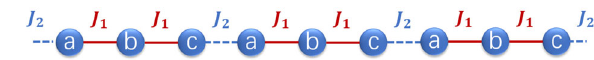
Fig. 1 Schematic representation of a trimer spin chain. J 1 and J 2 represent the two different antiferromagnetic nearest-neighbor Heisenberg intratrimer and intertrimer couplings, respectively. We here consider systems with J 1 ≥ J 2 > 0. We will use the letters a , b , c as indicated to refer to the three spins within a given unit